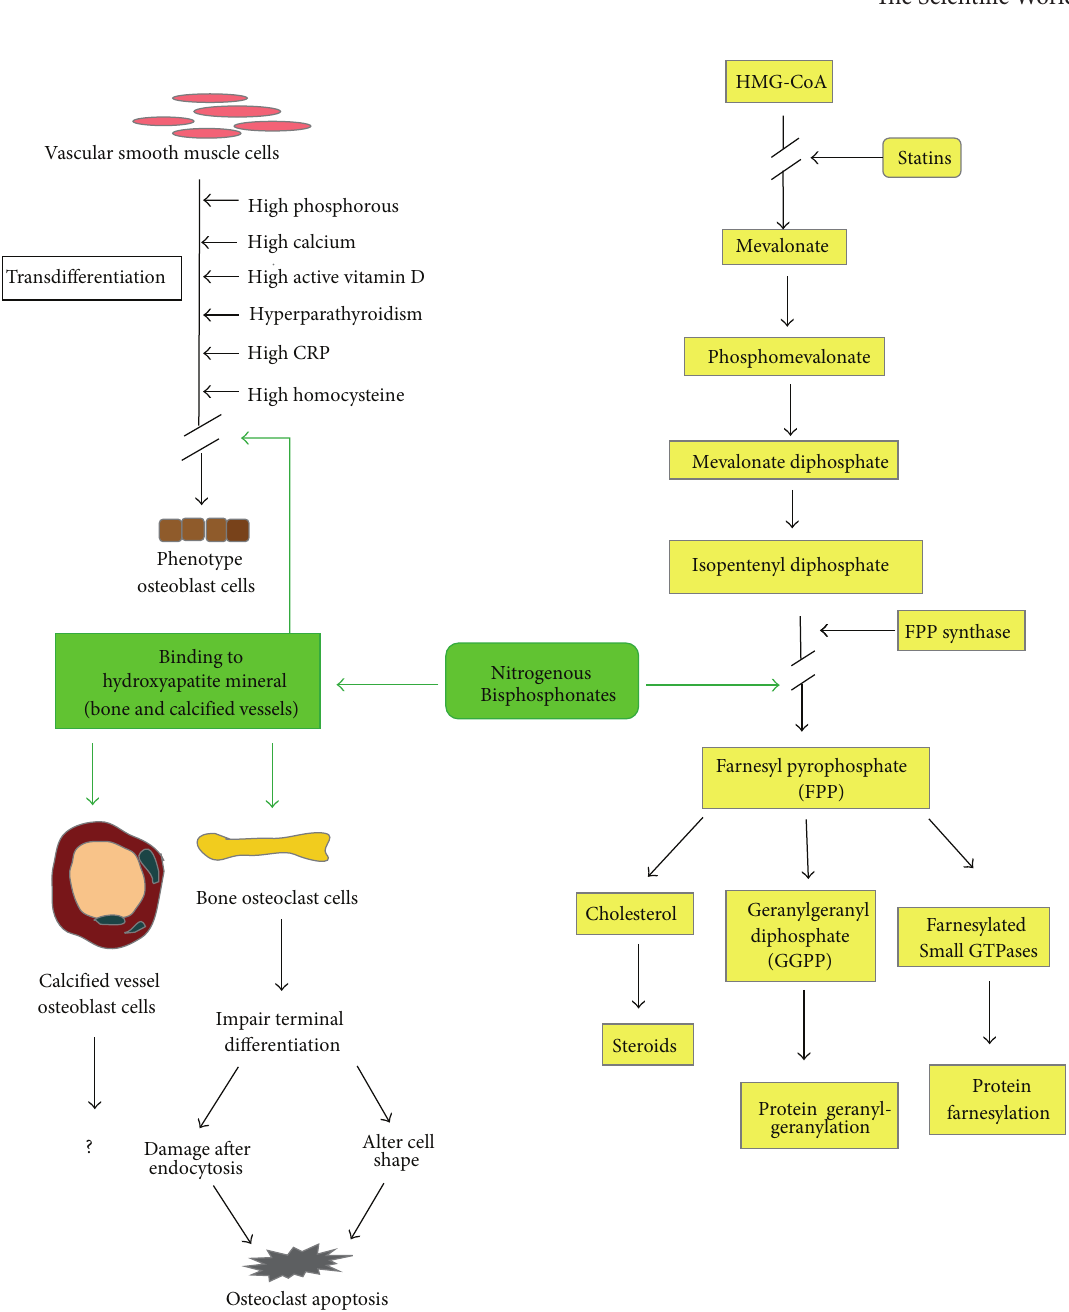
Figure 2: Effects of nitrogenous bisphosphonate on mevalonate metabolism (right) and on the osteoclasts of bone and calcified vessels (left).